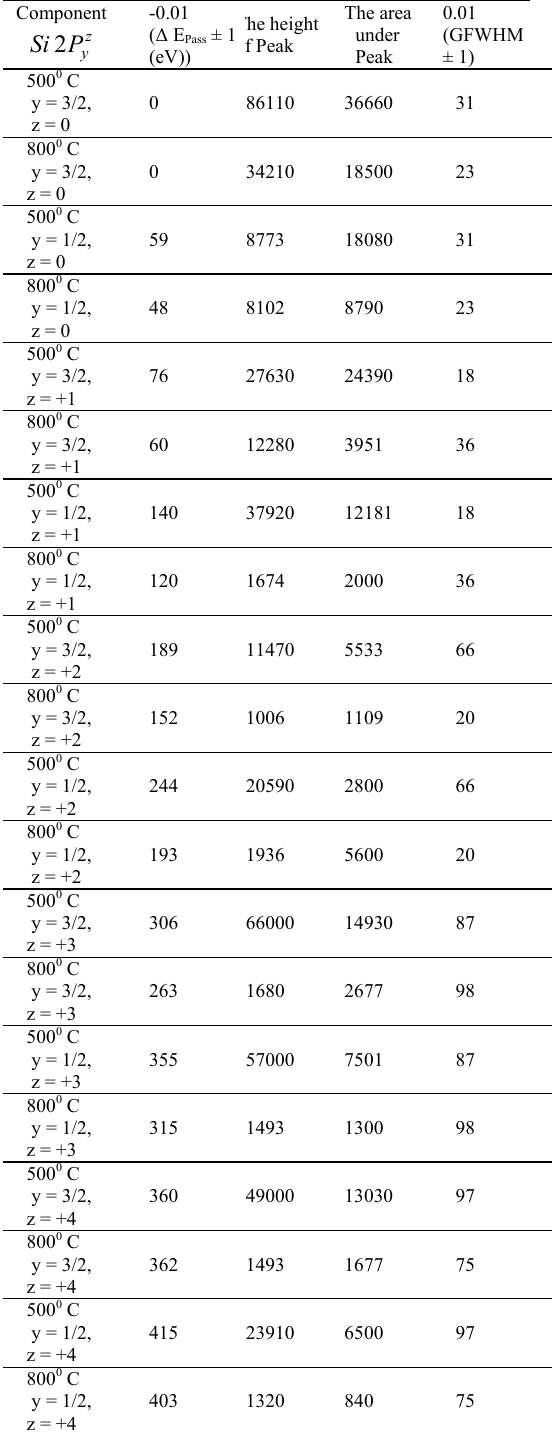
Table 1. Fitting parameters for the spectrum of SiO2/ Si(100) after exposure 90 min at 5000C and 20 min at